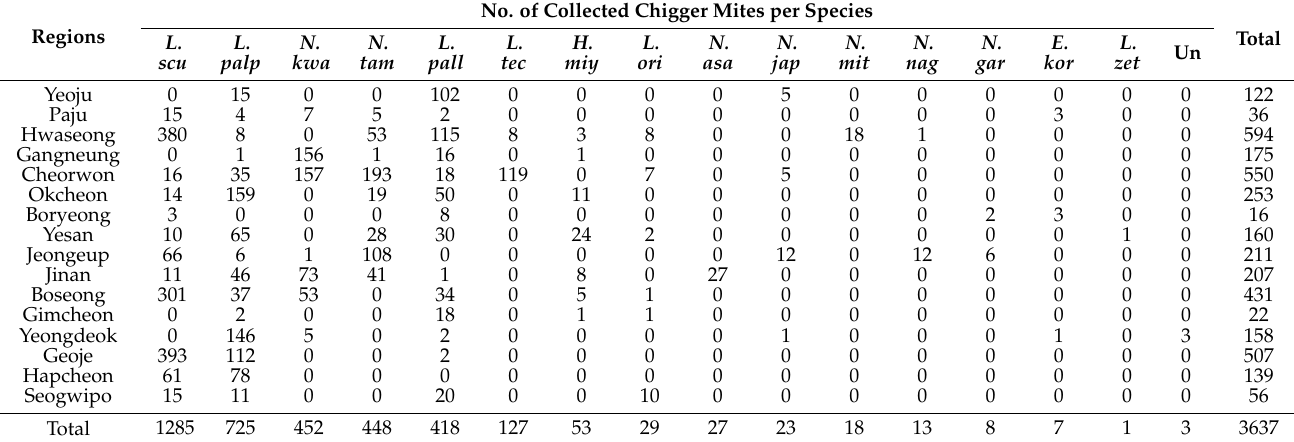
No. of Collected Chigger Mites per Species